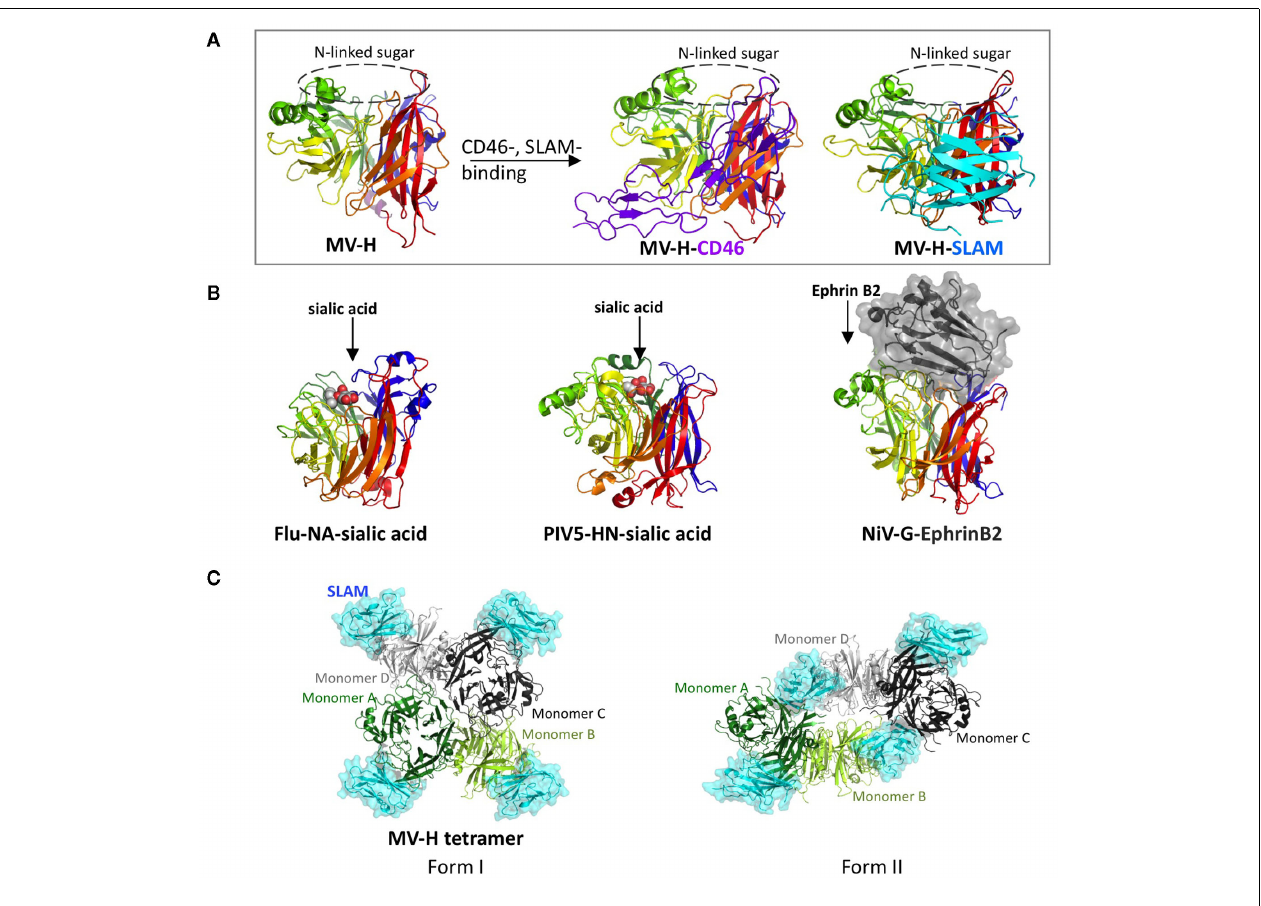
bound to sialic acid (middle), and NiV-G bound to ephrin B2 (right). Sialic acid (white and red) is indicated as sphere models, whereas ephrin B2 (black) is shown in surface presentation. (C) Top views of two forms of MV-H tetramer with each monomer bound to SLAM (cyan). MV-H monomers A (green) and B (light green) form one dimer, whereas monomers C (black) and D (gray) form